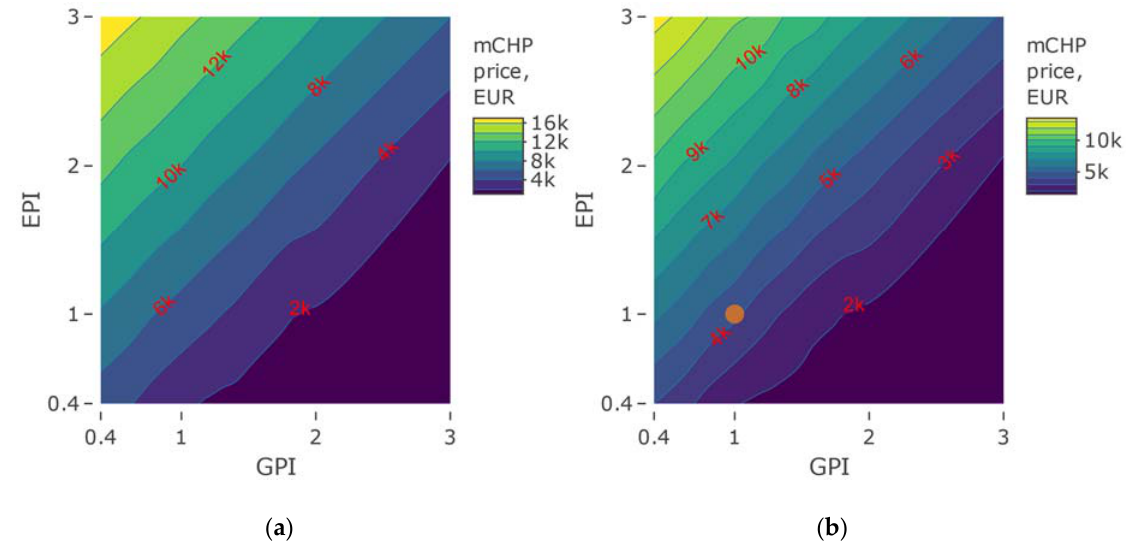
Figure 16. mCHP price, as an EPI and GPI function at which an investment in mCHP would be economically viable for: ( a ) 10,000 households; ( b ) 100,000 households, • SG100k for EPI = 1.0 and GPI = 1.0).